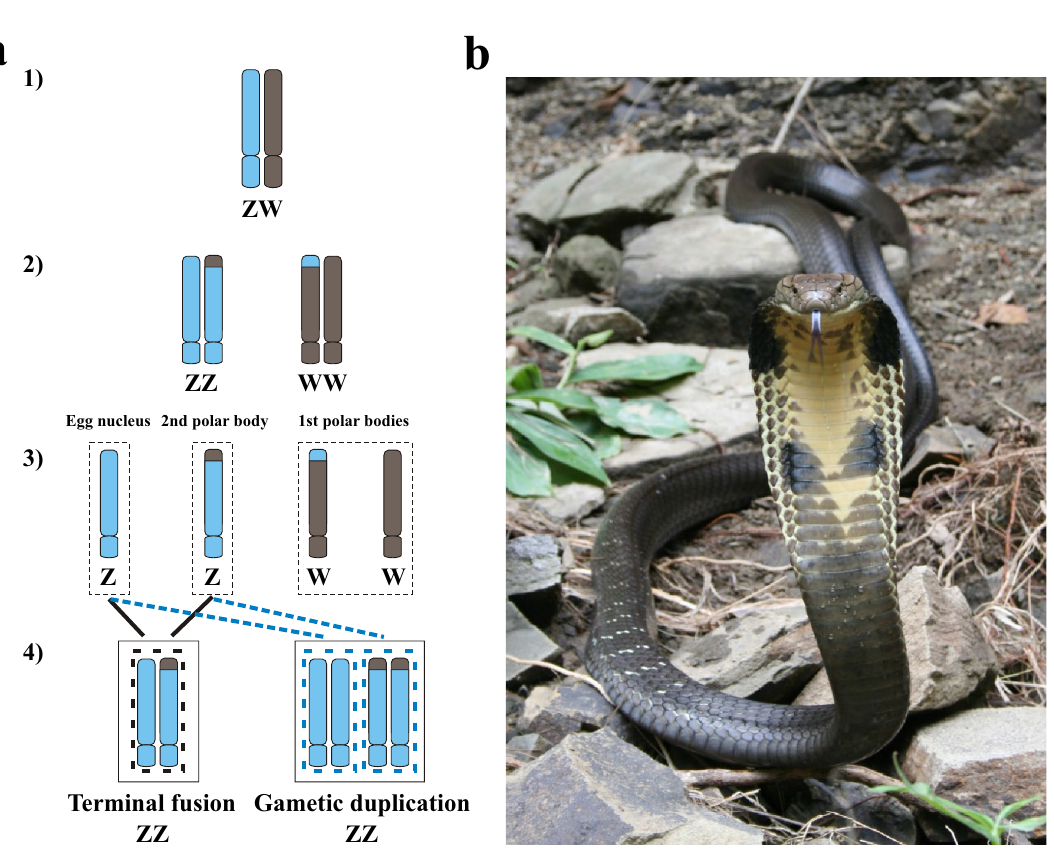
Figure 1. ( a ) Proposed mechanisms of automixis in snakes. (1) Primordial germ cell. (2) Meiotic products following DNA replication and recombination during the first round of cell division. (3) Meiotic products following the second round of cell division. (4) Potential sex chromosomal arrangements following terminal fusion and gametic duplication (here depicted for one Z chromosome). Note that parthenogens with a WW sex chromosome arrangement are not, at present, known to be viable. (Modified from 58 ). ( b ) Adult king cobra ( Ophiophagus hannah ). Photo courtesy of Freek